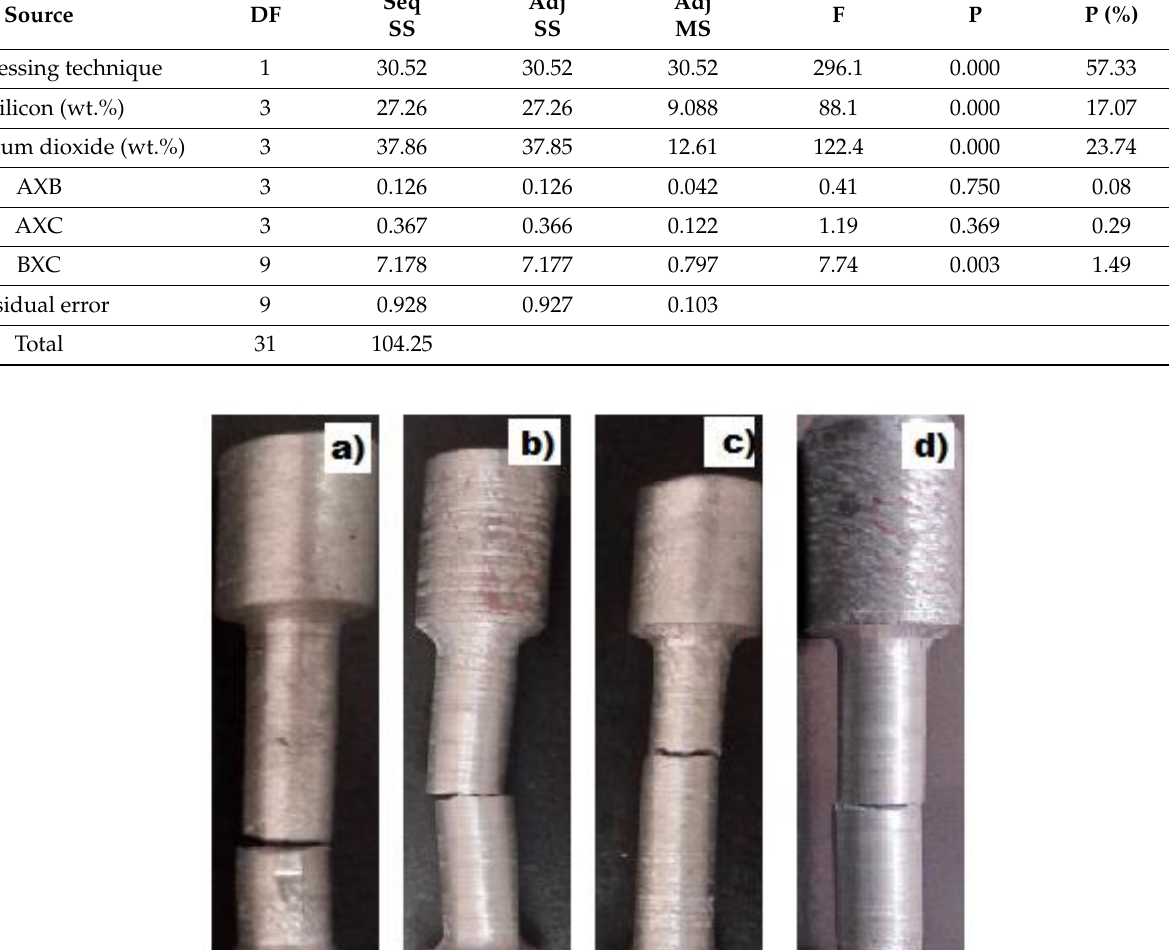
Table 8. ANOVA for SN ratios.